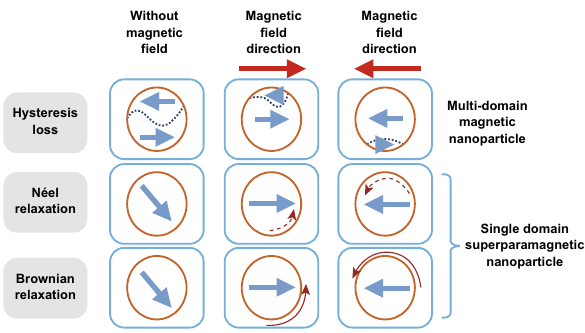
Fig. 4 Magnetic NPs interaction with magnetic field (MF). NPs are displayed as orange circles with blue arrows indicating the magnetic domains. Dark red arrows represent magnetic moment direction movements (solid) or changes (dashed). Reprinted under a Creative Common Licence CC-BY 4.0. Copyright 2020 from Ref. [18]. (Color figure